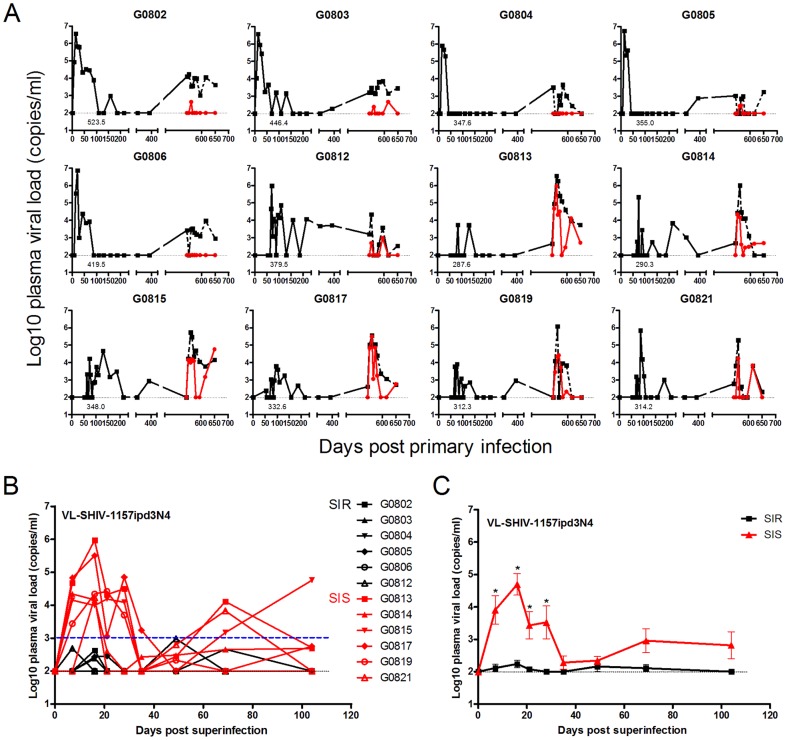
Plasma viral loads following primary infection and superinfection in each monkey.(A) Kinetics of plasma viral loads of twelve monkeys with a SHIVSF162P3 primary infection (black lines) followed by SHIV-1157ipd3N4 superinfection (red lines). Total viral loads of twelve monkeys after superinfection are shown by black dashed lines. The area under the curve (AUC) of SHIVSF162P3 viremia of each monkey for the acute infection (0–130 days) was indicated. (B) Kinetics of plasma SHIV-1157ipd3N4 loads in twelve monkeys after superinfection at each time point. The monkeys with plasma SHIV-1157ipd3N4 loads more than 103 copies per ml (blue dashed line) were defined as superinfection-sensitive group (SIS) and those less than 103 copies per ml as superinfection-resistant group (SIR). (C) Kinetics of the average viral load of SHIV-1157ipd3N4 in SIS (red line) and SIR monkeys (black line) (Mann-Whitney U test, *p<0.05). Viral loads are shown as log10 copies of viral load/ml of plasma and the limits of detection are 100 copies per ml (black dotted lines).